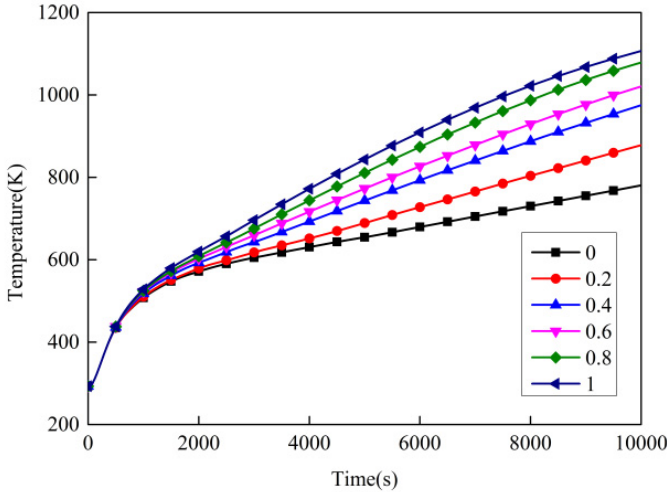
Figure 17. Temperature variation over time with different intra-pore emissivity.